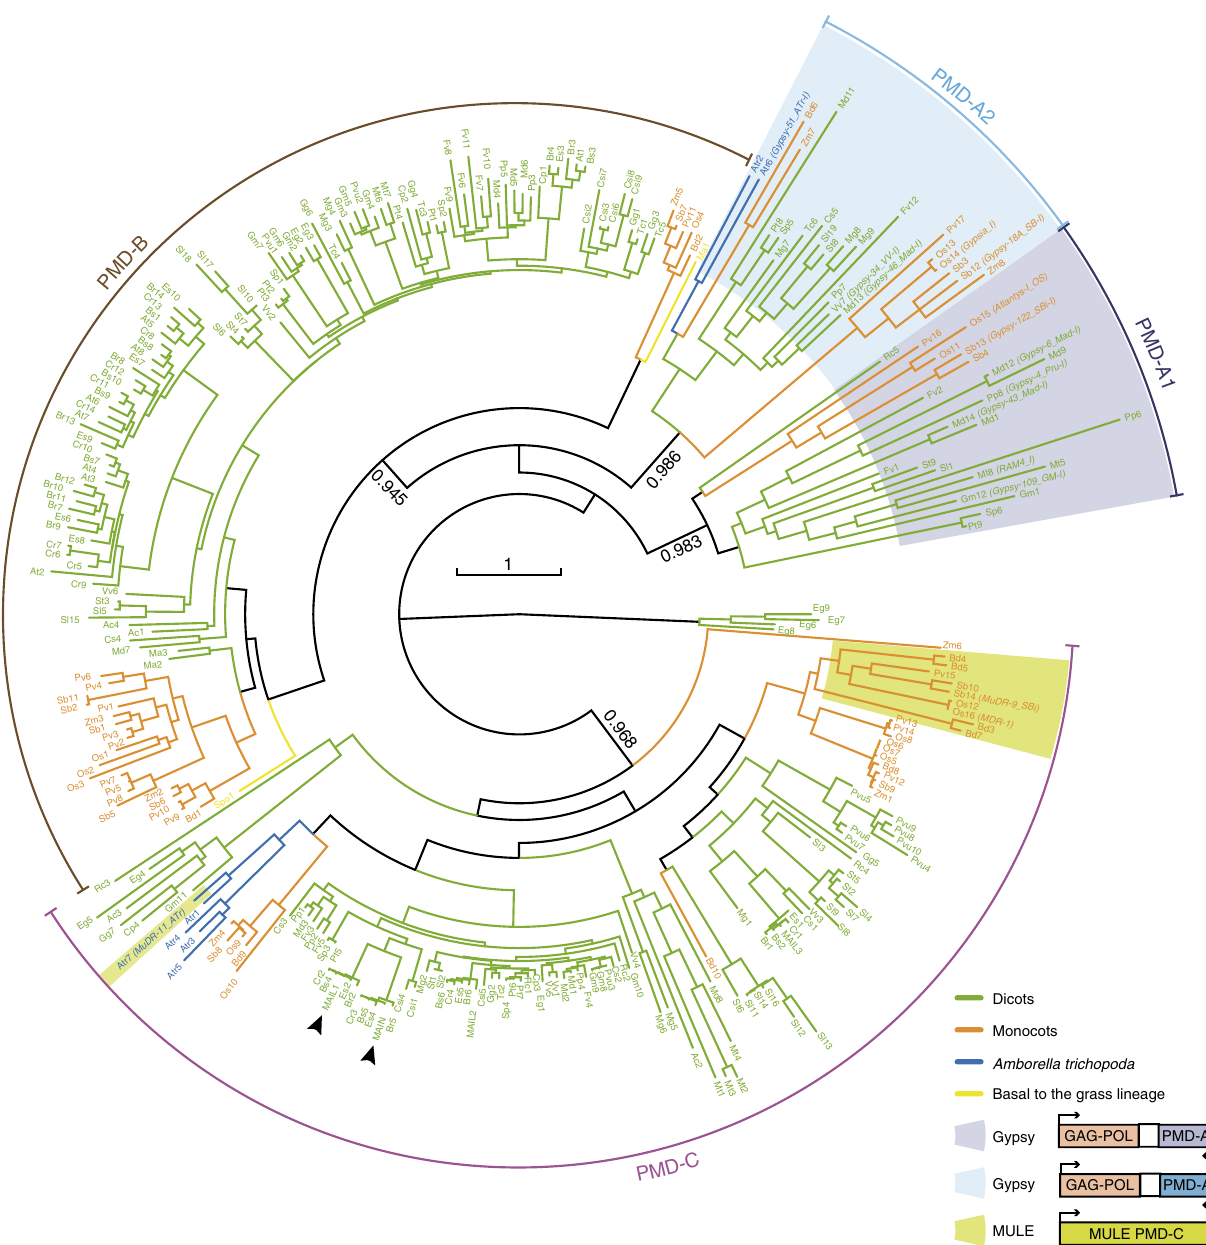
Figure 6 | MAIL1 and MAIN contain a TE-related plant mobile domain. A phylogenetic tree was built from 308 PMDs from 33 species representing the diversity of this motif in angiosperms (Supplementary Data 3). The three clades A, B, C are indicated. The species codes are given in Supplementary Table 1. The colour code is the following: green for dicotyledonous species, orange for monocotyledon species, blue for the basal Amborella trichopoda and yellow for the two species that are basal to the grass lineage. Names of the TE sequences extracted from the Repbase database are presented in parenthesis. PMDs associated with TEs are highlighted in violet, blue or green depending on their clade and a schematic representation of their organization is shown. Other PMDs are associated with non-TE PCGs. MAIL1 and MAIN proteins are indicated with arrow heads. Statistical supports of key nodes calculated with the approximate likelihood-ratio test are indicated. Scale bar indicates one